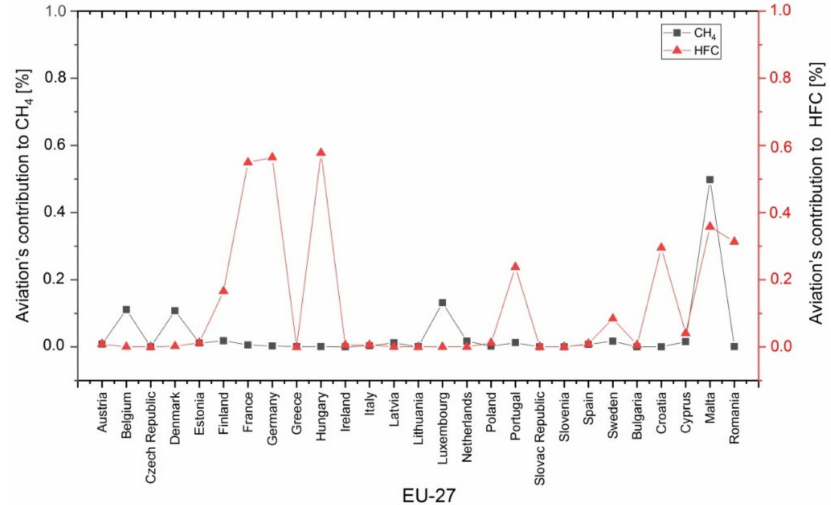
Figure 7. Percentage of aviation’s contribution to methane (CH4) and hydrofluorocarbons (HFC) emissions in the 27 European Union (EU-27) member states (2018, %) [47].